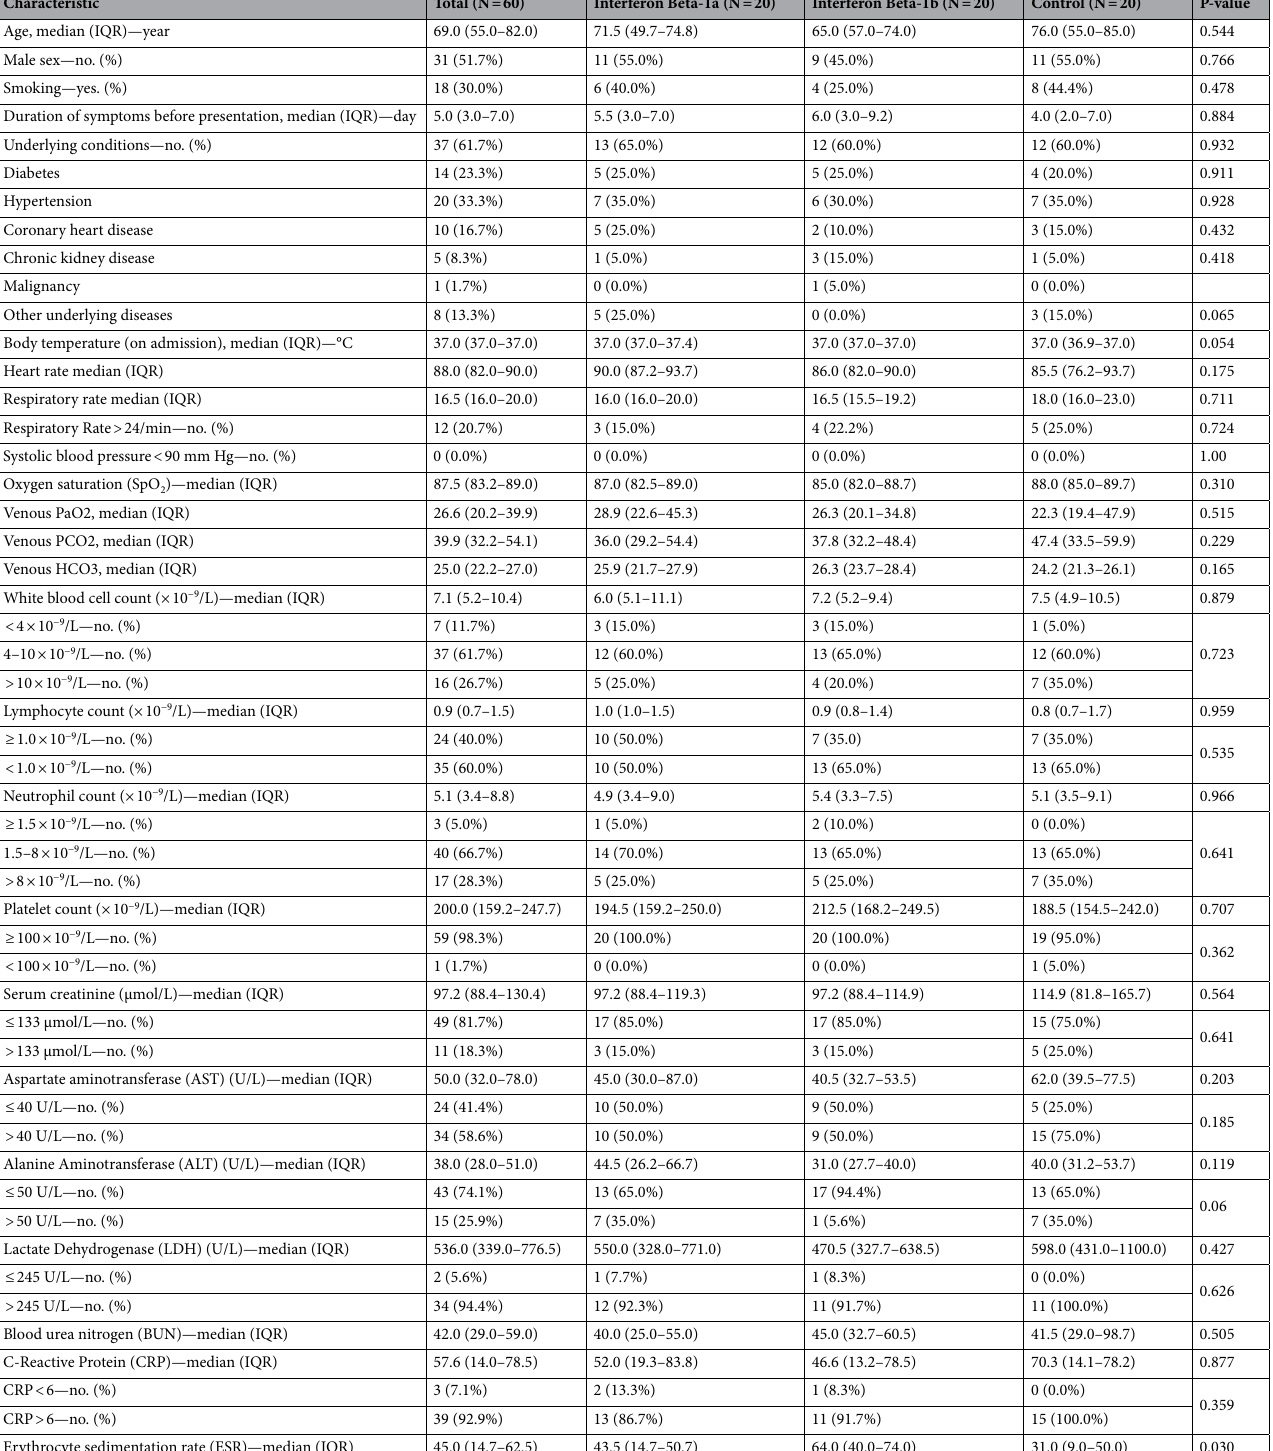
Table 1. Characteristics of the patients at baseline. The values shown are based on available data. Laboratory values for Aspartate Aminotransferase and Alanine Aminotransferase were available for 18 patients in the Interferon Beta-1b group. Values for Lactate Dehydrogenase were available for 13 patients in Interferon Beta-1a, 12 patients in the Interferon Beta-1b, and 11 patients in the control group. Values for C-Reactive Protein were available for 15 patients in Interferon Beta-1a, 12 patients in the Interferon Beta-1b, and 15 patients in the control group. IQR denotes the interquartile range. Quantitative measures were compared using the Kruskal–Wallis test. Categorical variables were compared using the Chi-Square